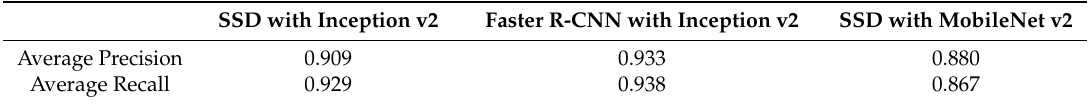
Table 3. Average Precision and Recall values for models